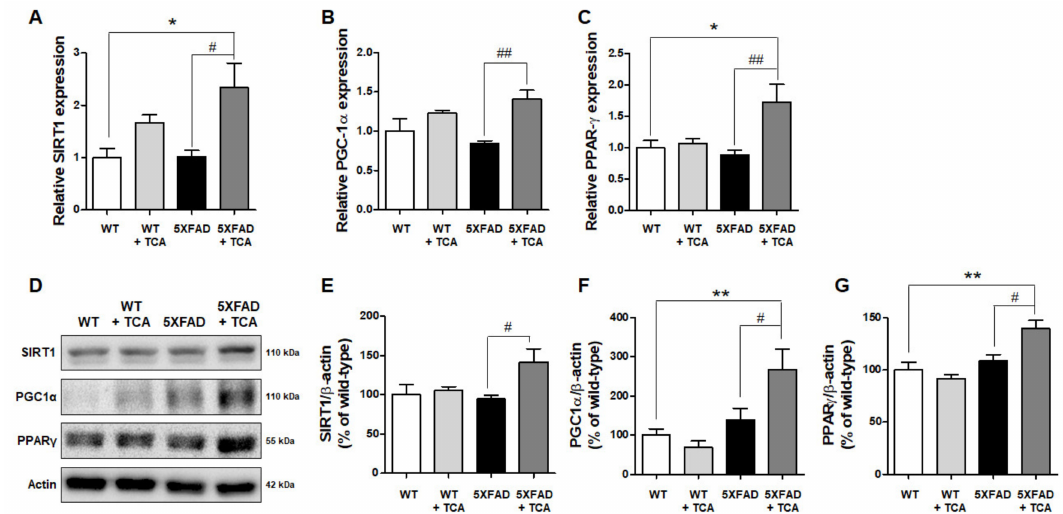
Figure 6. TCA activates the silent information regulator 1 (SIRT1)-peroxisome proliferator-activated receptor γ (PPAR γ ) coactivator 1 α (PGC1 α )-PPAR γ pathway that regulates the expression of BACE1